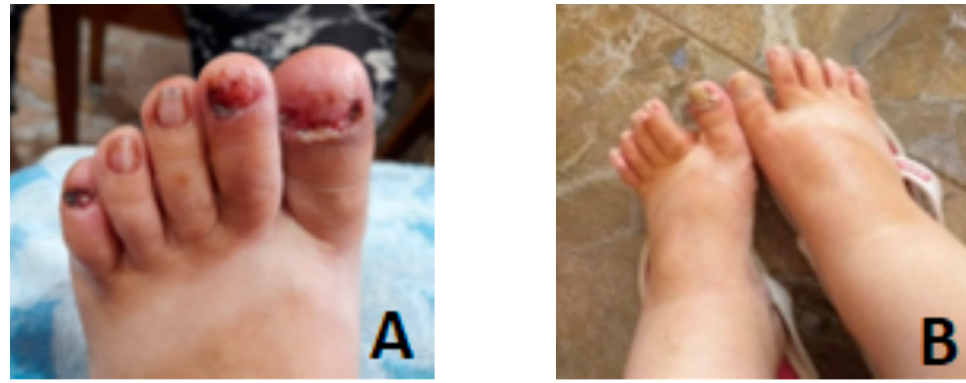
Figure 3. Ungual fibromas: ( A ) after surgery; ( B ) before surgery.